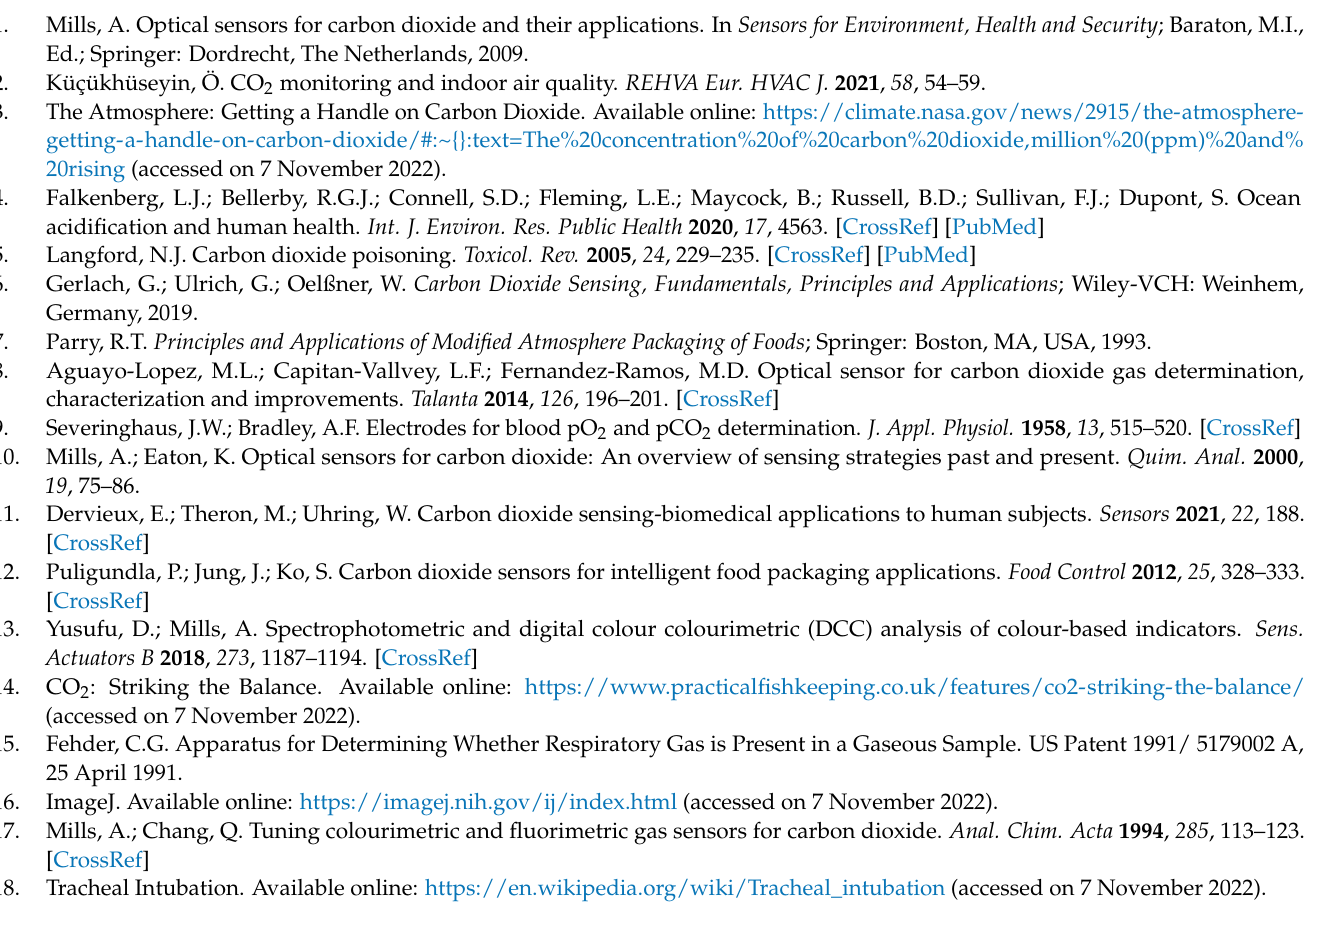
(c) subsequent plot of A vs A’ for the same solution, with values of A and A’ determined from the UV/Vis spectrum in (b) and the photographic images in (a), respectively; Figure S6: Plots of A (cid:48) vs. % CO 2 for (black circles, solid line) the lab-based and (open circles, broken line) the commercial CR-based capnography CO 2 indicators. Data from Table S4; Figure S7: Normal capnography waveform with (i) inspiration flat phase, (ii) expiration upstroke, (iii) alveolar plateau, and (iv) inspiration down- stroke; Table S1: Wavelengths of the absorption maxima for the deprotonated and protonated forms of the BTB and CR dyes in aqueous solution; Table S2: Structures and pKas of BTB and CR; Table S3: Measured RGB(red), and calculated A (cid:48) and R data as a function of % CO 2 for the lab-based and commercial BTB-based aquaria indicators; Table S4: Measured RGB(red), and calculated A (cid:48) and